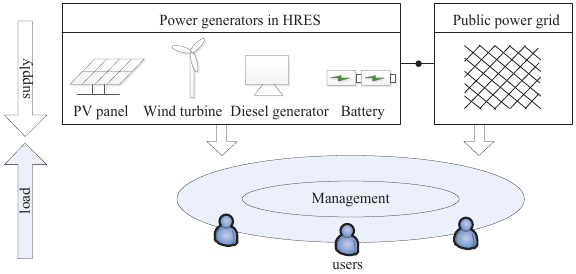
Figure 1. Illustration of the hybrid renewable energy system (HRES) with power grid. PV: